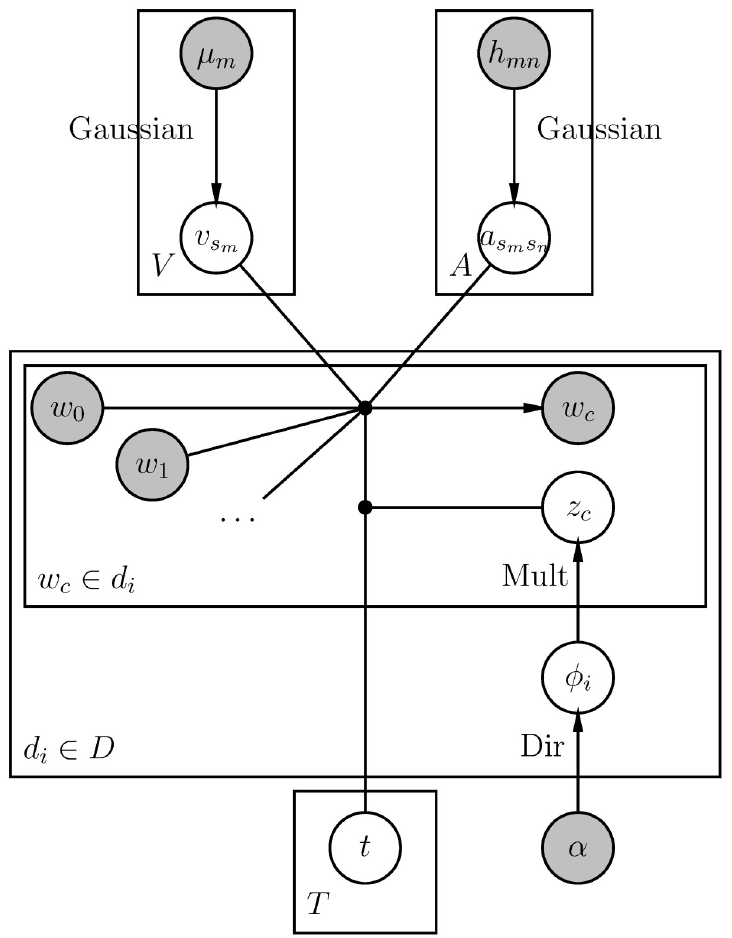
Fig 1. Graphical model of